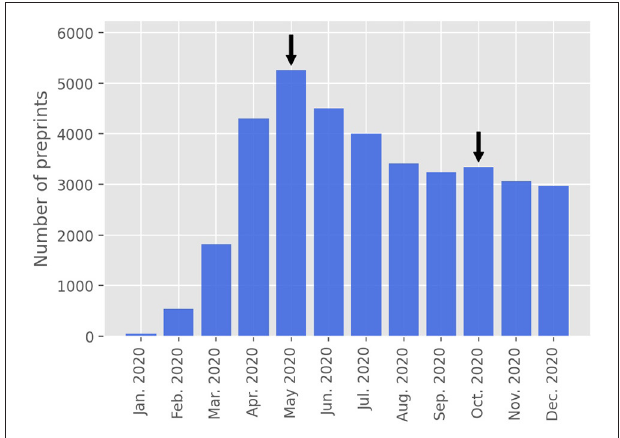
FIGURE 4 | Monthly number of COVID-19 preprints posted on online preprint repositories up to December, 31, 2020. The arrows indicate the main and secondary “peaks” in the